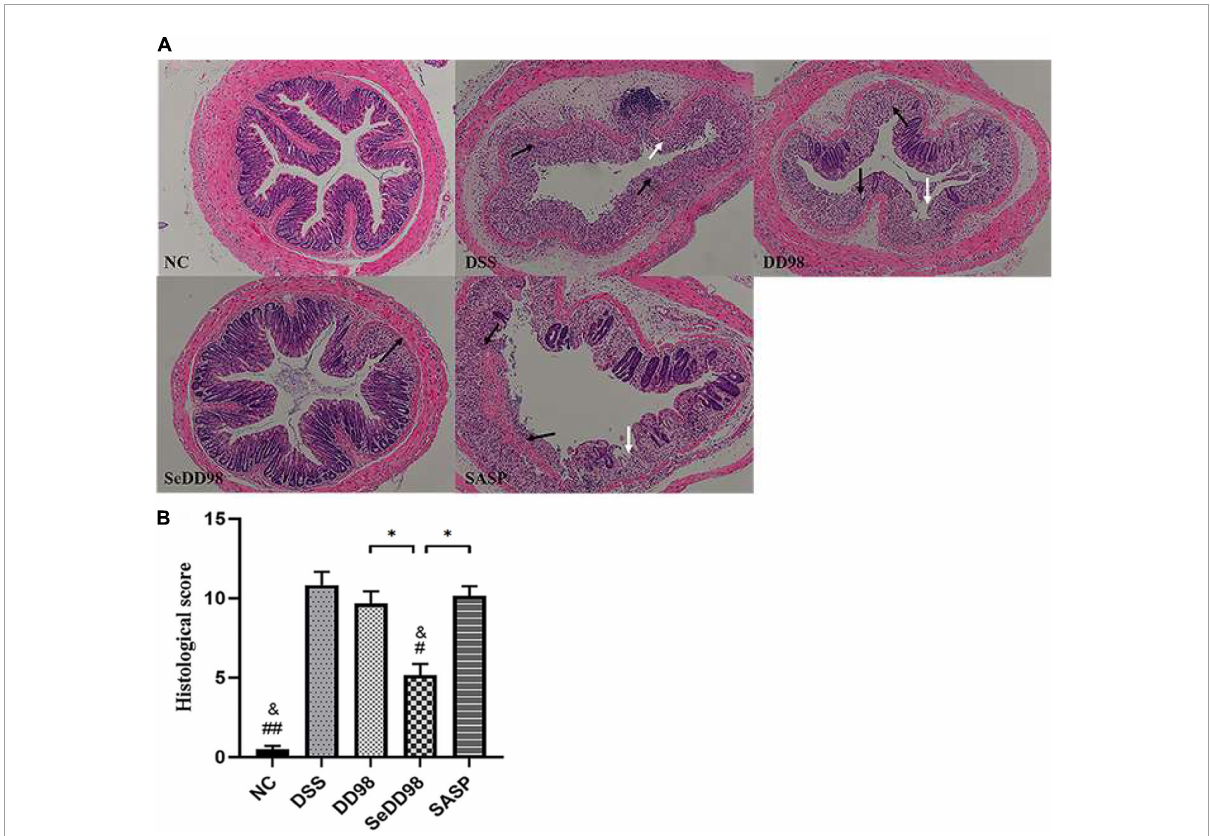
FIGURE3 (A) Representative photomicrographs of H&E-stained sections of colons. Black arrow, area of strong transmural inflammation with loss of crypt structure and depletion of goblet cells; white arrow, ulceration. (B) Histopathology scores of colon tissues ( n = 6). Data are shown as the mean ± SEM. ∗ p < 0.05. # p < 0.05 compared to DSS group. ## p < 0.01 compared to DSS group. & p > 0.05 compared to NC group. Histological score was analyzed by Kruskal–Wallis